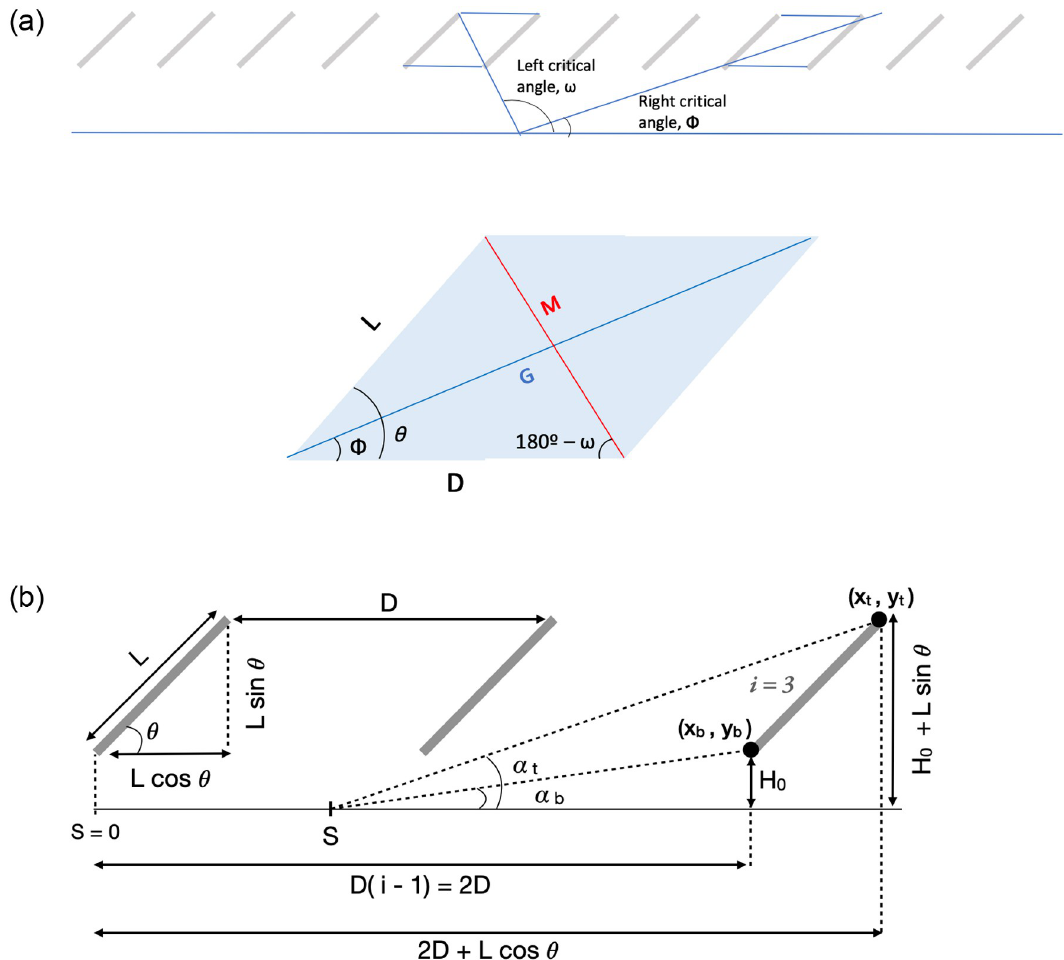
Fig 7. a. Derivation of critical angles for finding viewfactor. b. Derivation of top angle ( α t ) and bottom angle ( α b ) for panel i = 3. Flux over time: Determining panel temperature The heat flux at the ground is not only dependent on position S , but also time t , as stated in Eq 13. T and L are functions of air temperature, relative humidity, shortwave radiation, and P sky wind speed. These parameters (displayed in Fig 8) were measured by Adeh et al. in 2019 [12] at the same solar array used in this case study, and integrated into our determination of panel temperature and longwave radiation from the sky. The panel temperature at a given time was found by performing an energy balance on the panel (Fig 9) and solving Eq 14 numerically for T . The longwave radiation from adjacent pan- P els was not considered in the energy balance. where α = 0.2 is the panel albedo, ε is the electrical efficiency of the panel, R is the measured sun